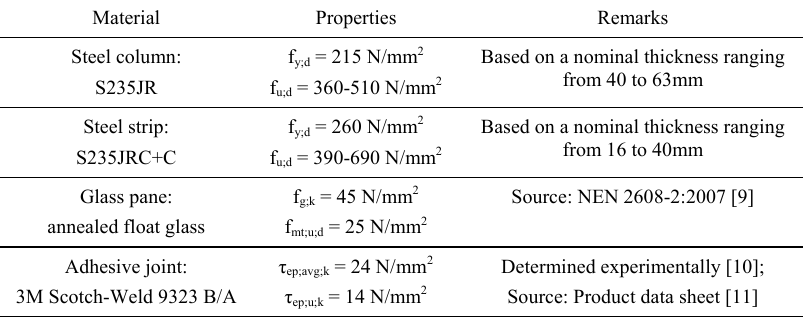
Figure 5: Typical test specimen. Table 2: Strength properties of the materials used in the test